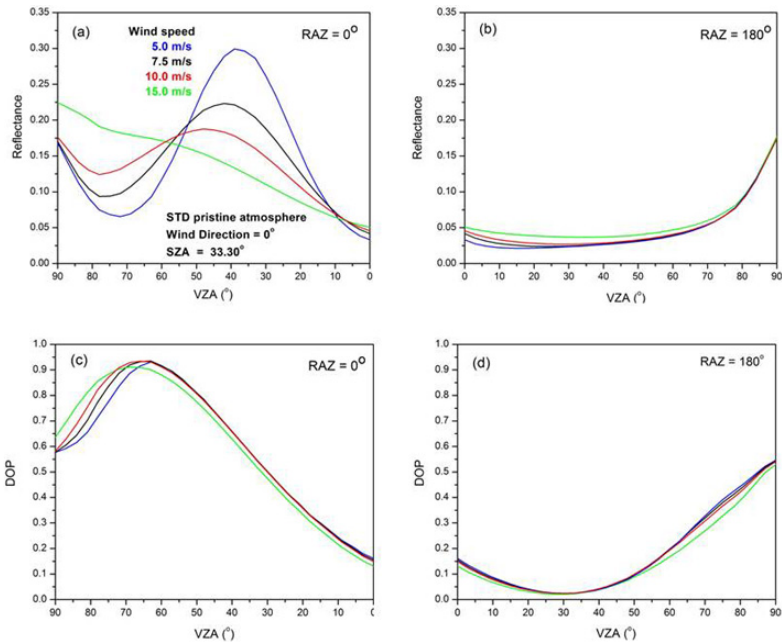
Fig. 8. The total reflectance and DOP of the ocean–atmosphere system on the principal plane, which is calculated with the ADRTM at a wavelength of 670nm. Pristine US standard (STD) atmosphere is used. The solar zenith angle is 33.30 ◦ . Wind direction is at 0 ◦ . Wind speeds are 5.0ms − 1 , 7.5ms − 1 , 10.0ms − 1 , and 15.0ms − 1 , respectively.